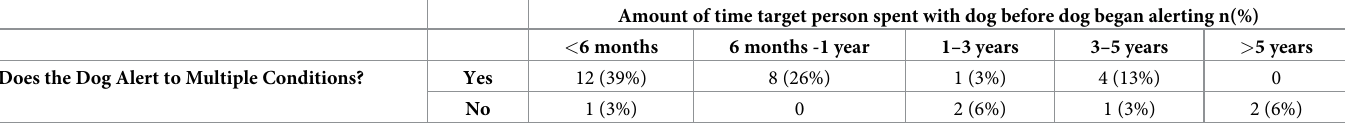
Table 5. The amount of time a dog with no formal training for medical alert spent with a target person before the dog began alerting to medical conditions, and whether or not the dog alerts to multiple conditions. Amount of time target person spent with dog before dog began alerting n(%)